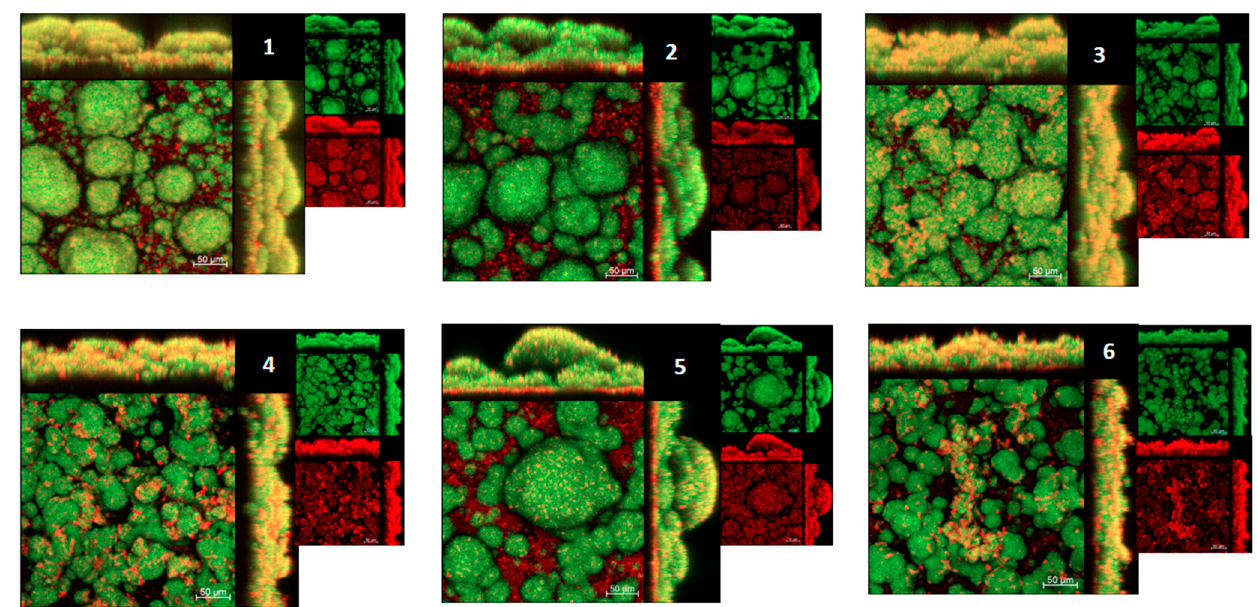
Figure 7. 3D architecture of S. mutans biofilm grown on sHA discs topically treated with SPE-C18 fractions. Representative confocal images of 67 h old biofilms are displayed in this figure. The red color represents exopolysaccharides produced by S. mutans (Alexa Fluor 647), and the green color represents bacterial cells (SYTO 9). The larger image in each set represents the overlay images of the smaller red and green channels (50 µm scale bars), which are shown separately at a smaller size. 1.